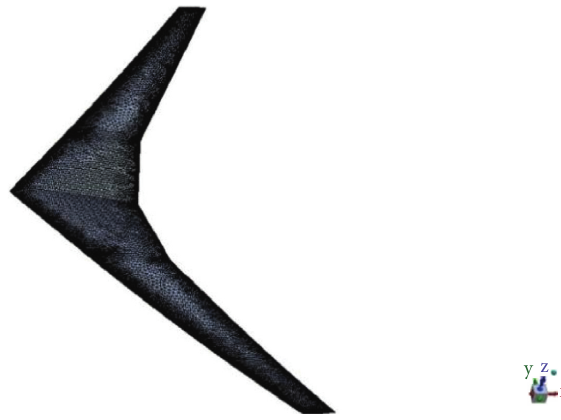
Figure 6: Mesh model of the wing geometry model.